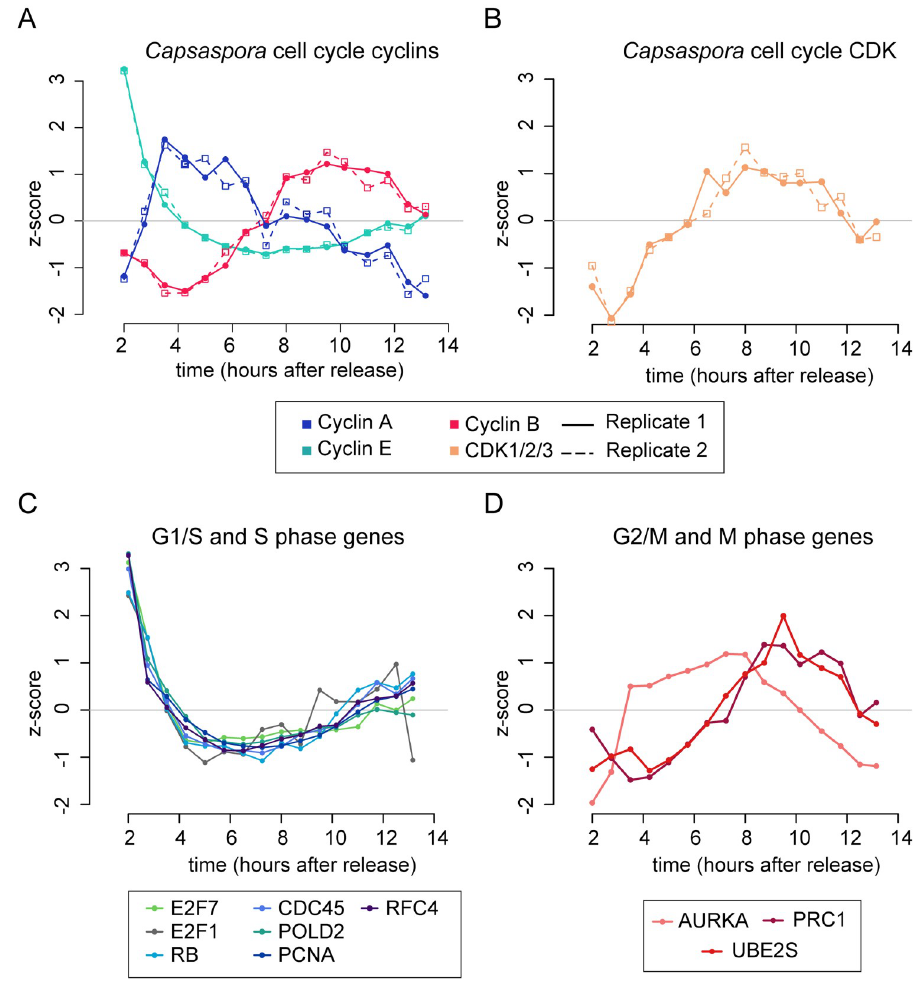
Fig 5. Dynamics of the cyclin-CDK system and other cell cycle regulators in Capsaspora . A : Gene expression profile of the Cyclin A, B, and E genes found in Capsaspora . B : Gene expression profile of the Capsaspora orthologue of CDK1/2/3 found by phylogenetic analyses (see S9 Fig). Normal and dashed lines indicate replicates 1 and 2, respectively. C : Gene expression level of Capsaspora orthologues of several G1/S regulators in animals. D : Gene expression level of Capsaspora orthologues of several G2/M regulators in animals. Genes in C and D as described by [32,44,45,93]. A full list is depicted in S12 and S13 Text.